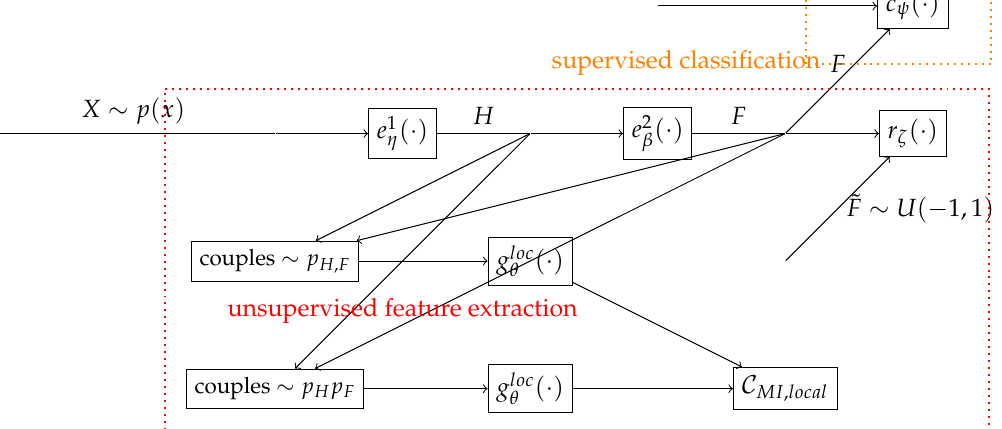
Figure 5. Neural Network architecture (Training). The dashed red box contains the unsupervised feature extraction part, while the orange one contains the supervised classification.